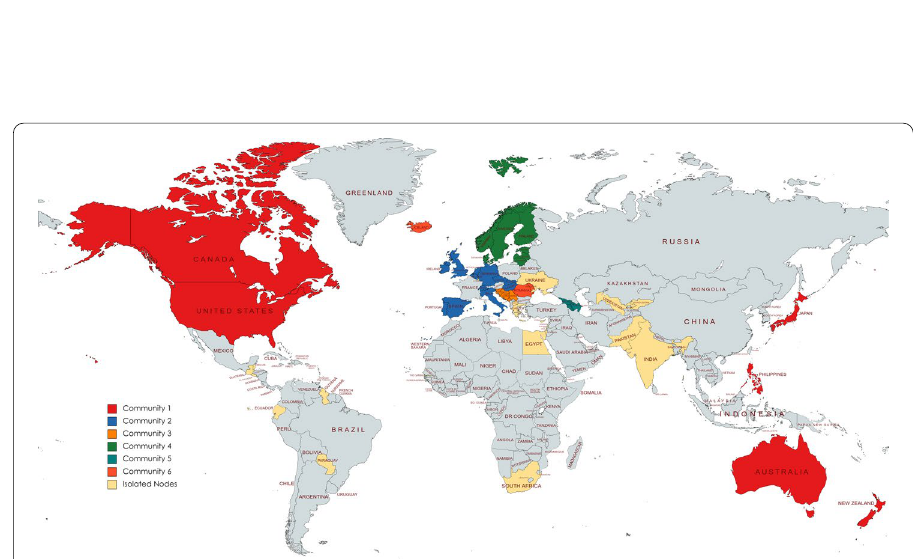
Fig. 4 World map with the optimal community structure in